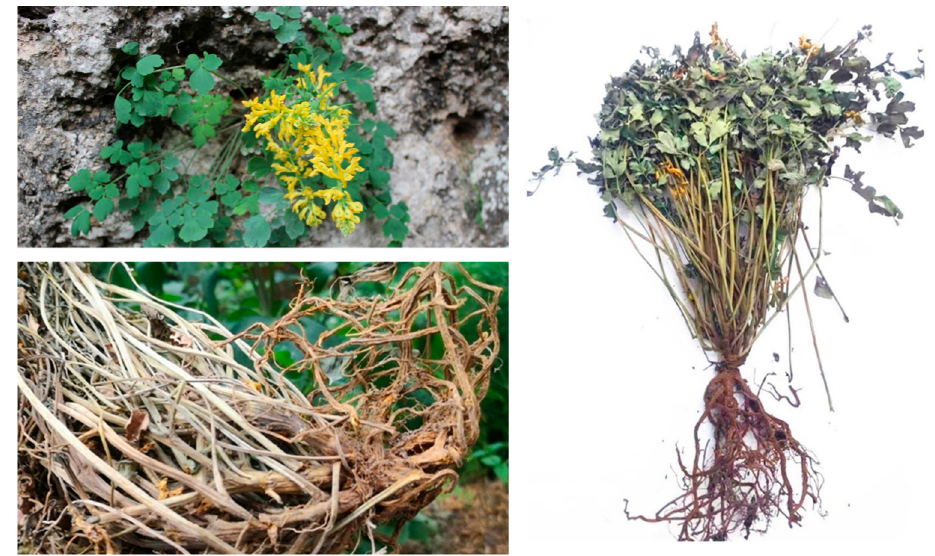
Figure 1. The pictures of Corydalis saxicola Bunting.